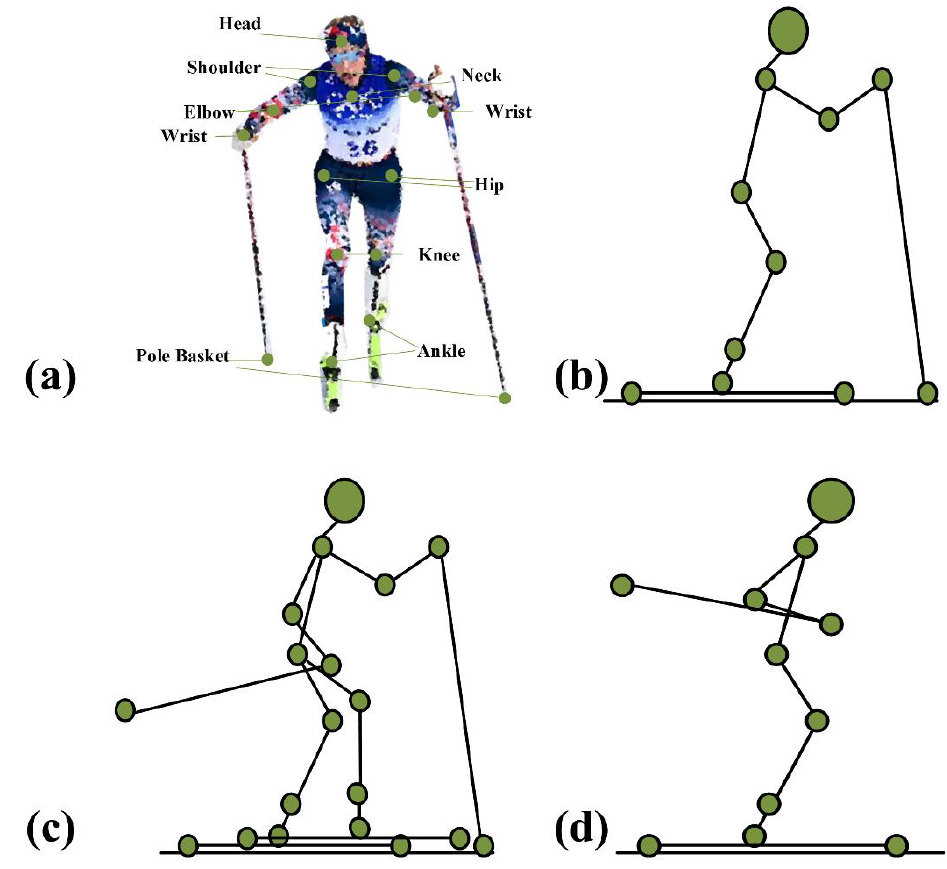
Figure 1. The key-point position and skiing sub-actions. ( a ) shows the key points of our work. ( b ) shows the DP action. ( c ) shows DS action. ( d ) describes the DT action.